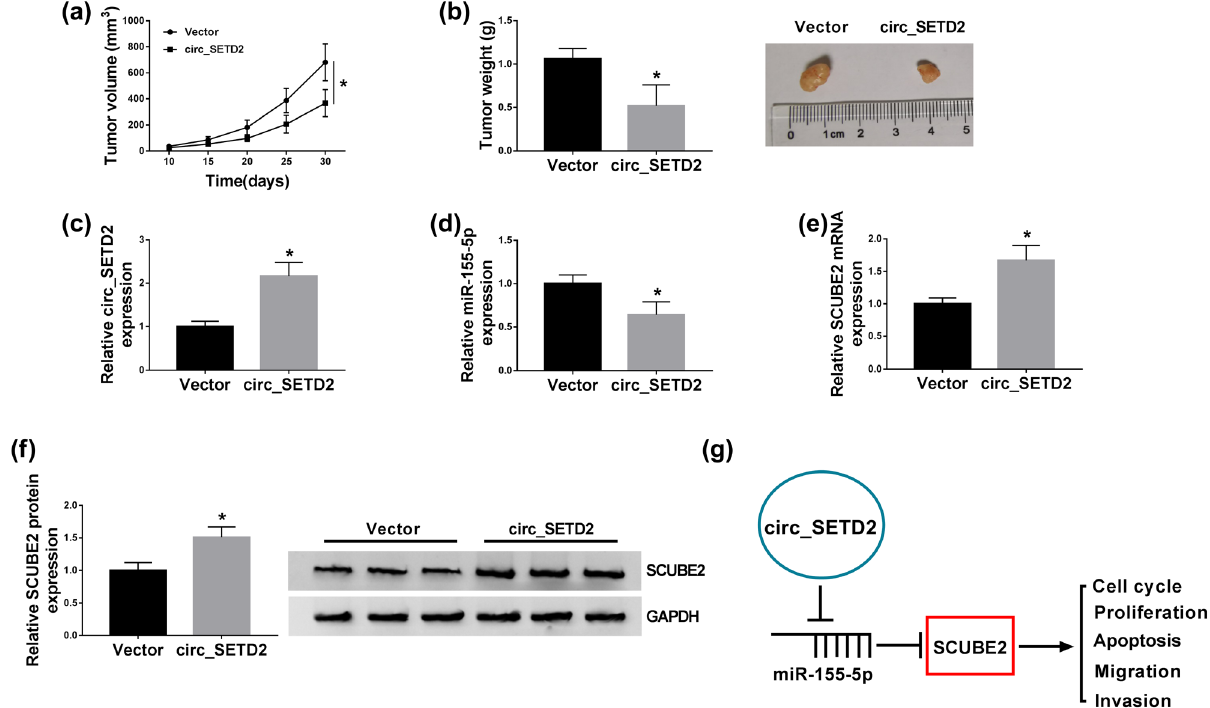
Figure 7: circ_SETD2 overexpression repressed BC growth in vivo . ( a ) From day 10, tumor volume was measured every 5 days until day 30. ( b ) Tumor weight was assessed on day 30 after injection. ( c and d ) The expression of circ_SETD2 and miR - 155 - 5p in tumor tissues of the circ_SETD2 and vector groups was analyzed by qRT - PCR. ( e and f ) The expression of SCUBE2 mRNA and protein in tumor tissues of the circ_SETD2 and vector groups was examined with qRT - PCR or western blot analysis. ( g ) Schematic diagram of the mechanism of circ_SETD2 involved in BC advancement. The data are presented as mean ± standard deviation; paired Student ’ s t test was utilized to compare the di ff erences between the circ_SETD2 and vector groups; the experiments in vivo were repeated three times. * P <